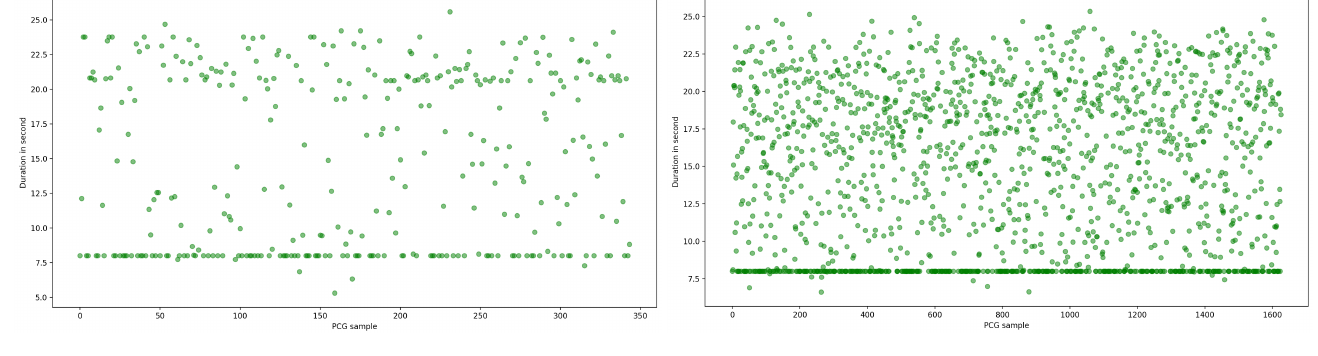
Figure 12. The PCG data distribution of normal and abnormal classes after selecting the highest dense cluster issued from GMM biclustering.